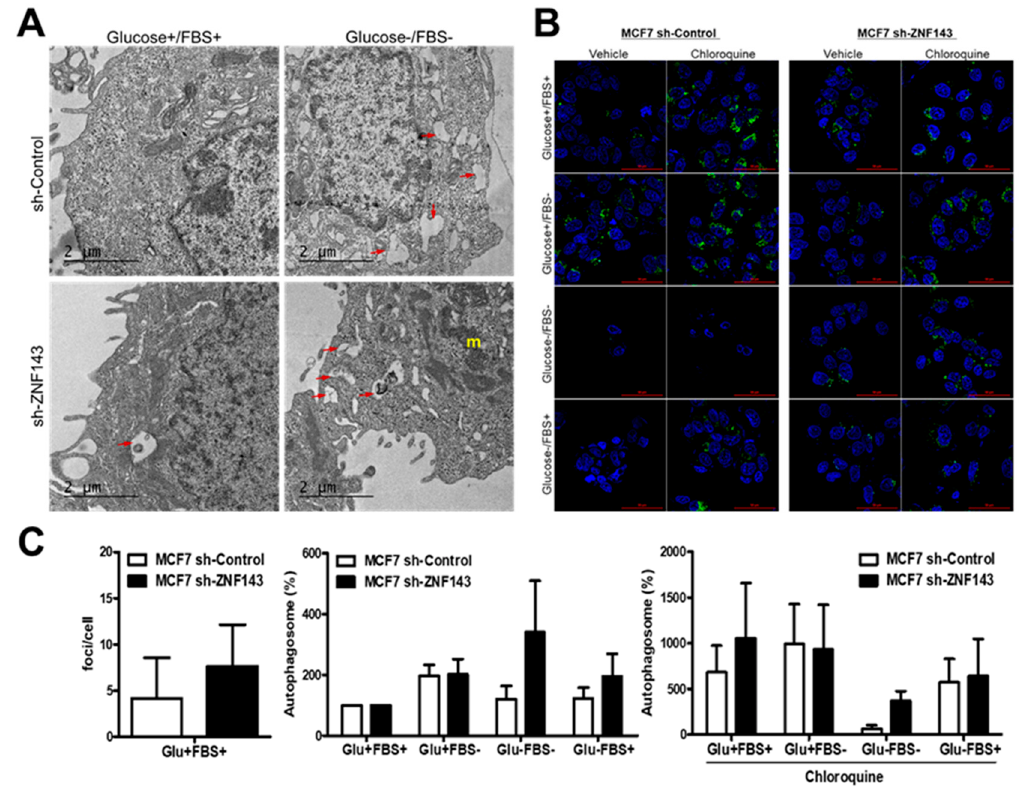
Figure 2. More autophagic vesicles are observed in ZNF143 knockdown cells than in control cells. ( A ) Growing cells were maintained in growing media or fetal bovine serum-free media for 24 h and then fixed for TEM. ( B , C ) cells were grown on coverslips for 24 h and then exposed to four different media for an additional 24 h to monitor autophagic processes by autophagosome-selective marker labeling in live cells. Foci were visualized by confocal microscopy, quantified by using ImageJ software, and statistically analyzed by GraphPad software ( C ). Results shown are representative of at least three independent experiments.